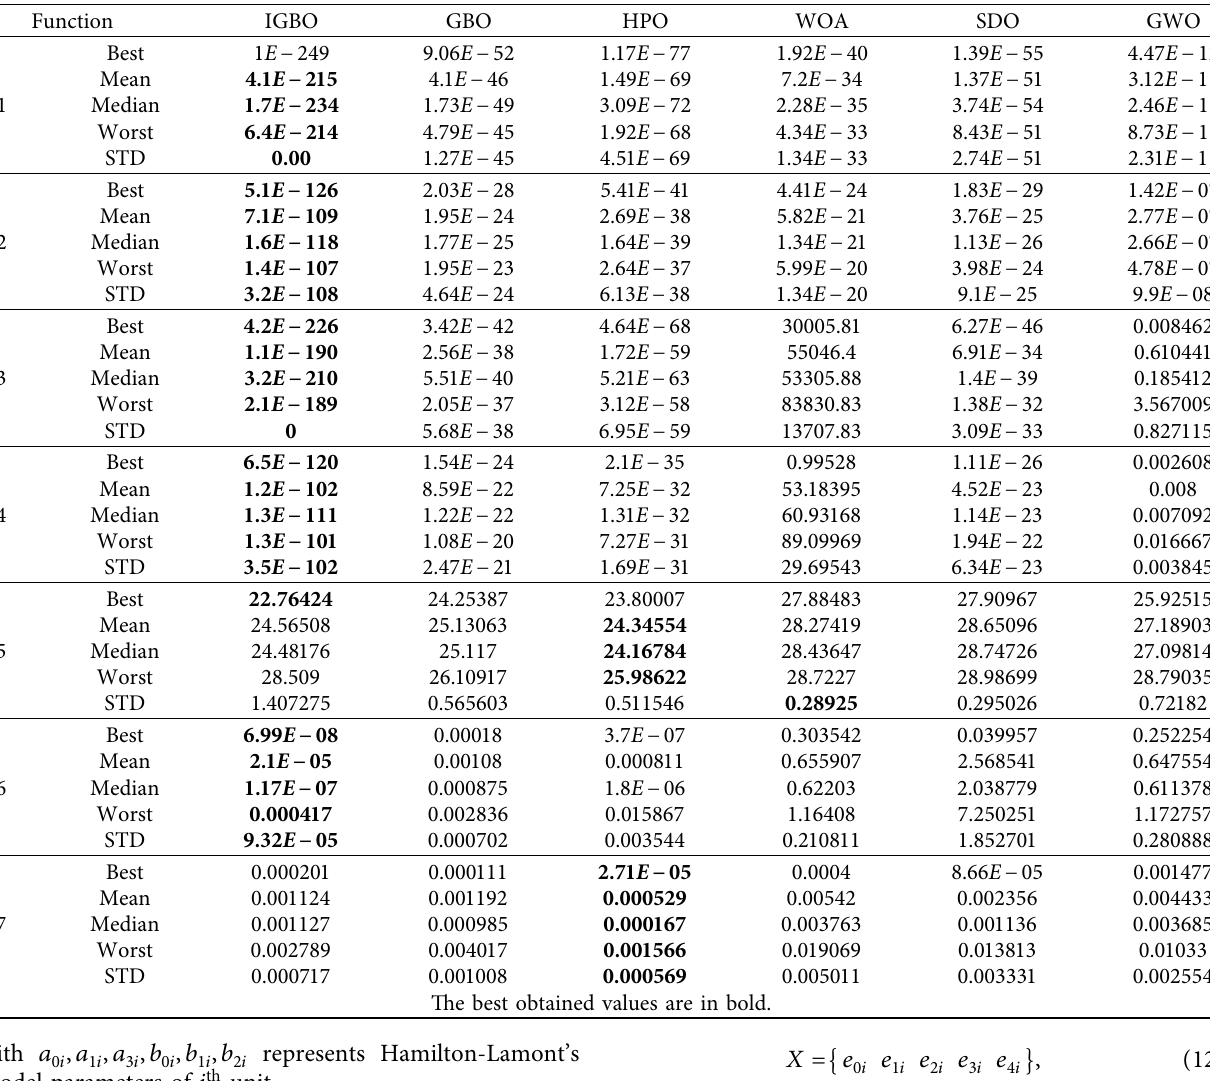
Table 1: Results of unimodal benchmark